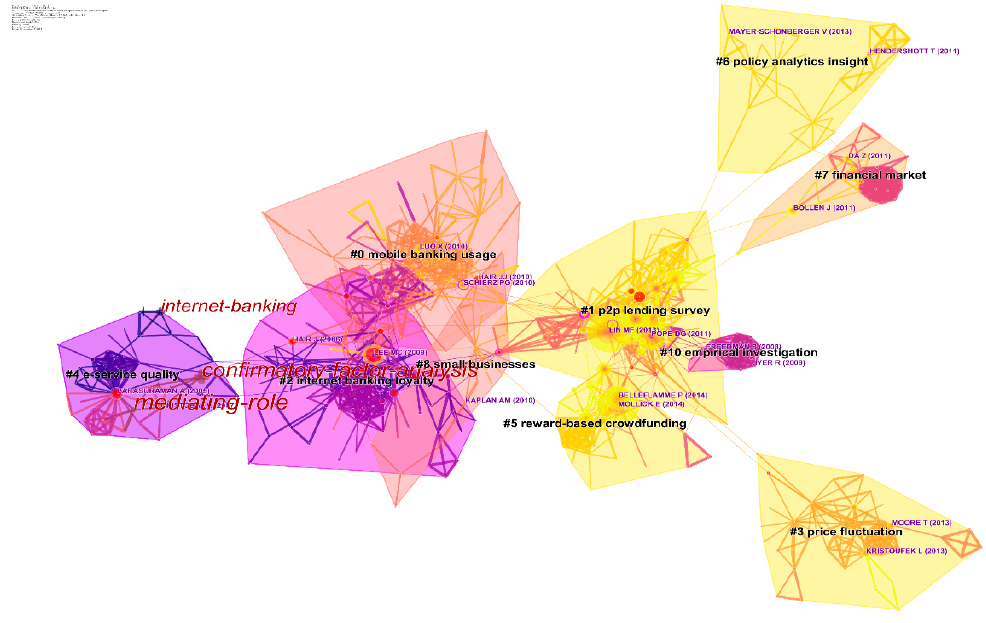
Figure 3. Co-citation networks.